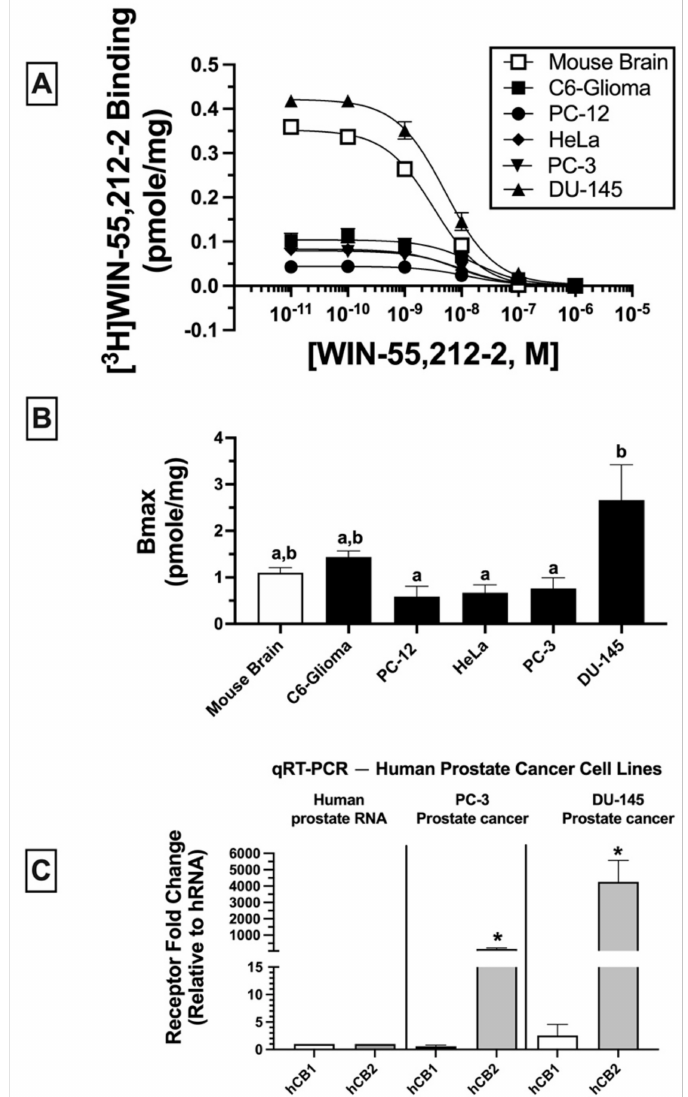
Figure 2. Homologous receptor binding: cancer cell lines express non-canonical CBRs in varying den- sities (B MAX ). ( A ) Homologous receptor binding studies demonstrated that WIN-55,212-2 produced concentration-dependent (10 − 11 to 10 − 6 M) displacement of [ 3 H]-WIN-55,212-2 (1 nM) binding, a one-site model fitting best. Data for each concentration represent the mean ± SEM of data collected from a minimum of three experiments, with each data point conducted in triplicate for each ex- periment. ( B ) Receptor density (B MAX ) was compared across cancer cell lines and mouse brain via non-linear regression curve-fitting utilizing a one-site homologous competition binding equation to determine K D and B MAX values. a,b Bars designated with different letters are significantly different from each other (one-way ANOVA followed by Tukey’s post hoc test for multiple comparisons, p < 0.05). ( C ) qRT-PCR was used to examine mRNA levels for canonical human CB1 and CB2Rs. Data are presented as fold changes in mRNA levels in either PC-3 ( middle panel) or DU-145 ( right panel) cells compared to human prostate mRNA control values that were assigned an arbitrary value of 1 ( left panel). Significantly different from human prostate mRNA control (one-way ANOVA followed by Dunnett’s post hoc test, * p <